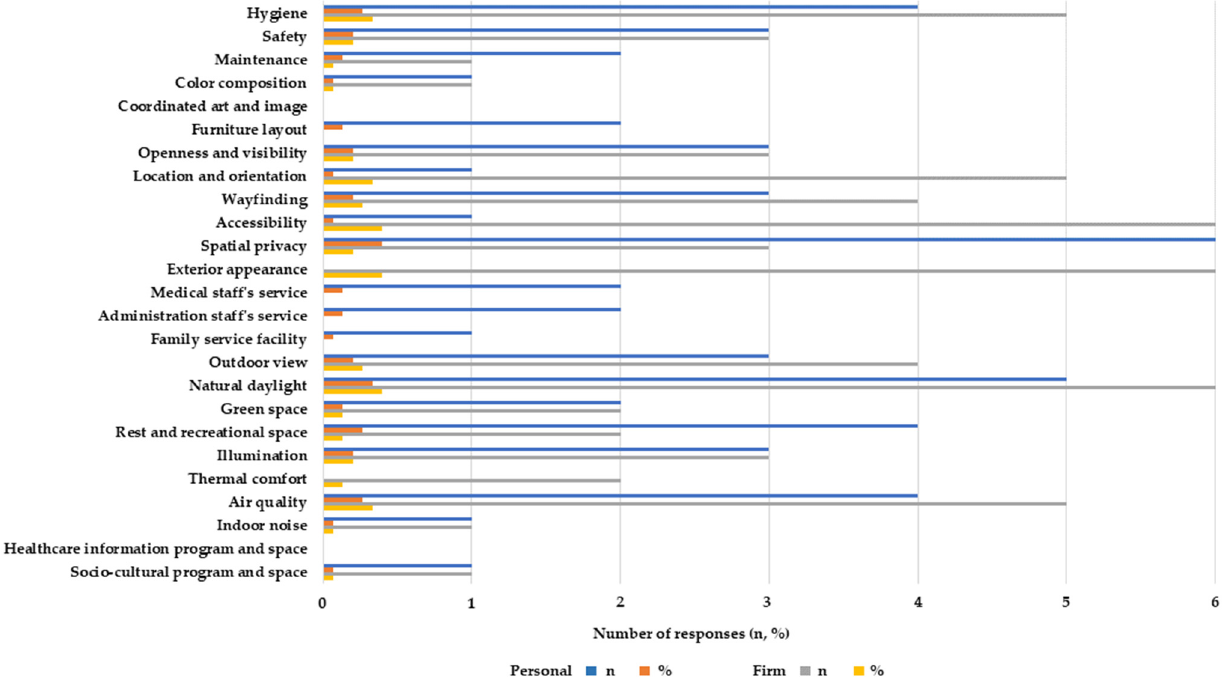
Figure 1. Participants’ personal priority and their firms’ priority in design implementation of the therapeutic healthcare environmental variables (Appendix A: Table A1).